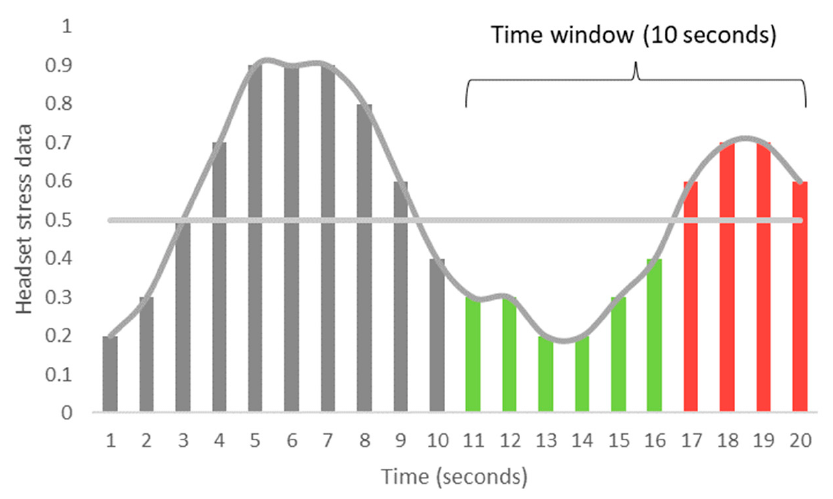
Figure 10. Example of stress processing from the signal obtained from the headset.